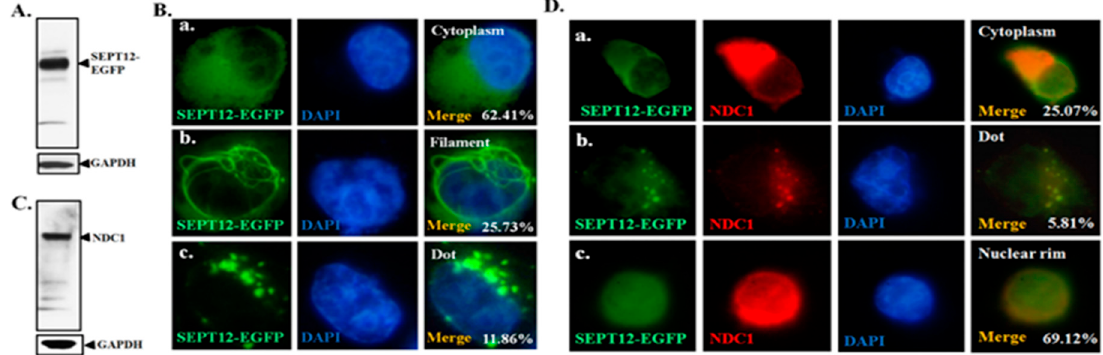
Figure 4. Effects of NDC1 overexpression on SEPT12 localization. ( A ) Western blotting of cells transfected with SEPT12-EGFP; ( B ) IFA results showing SEPT12-EGFP patterns: ( a ) localized at cytoplasm, ( b ) fibrous, or ( c ) dot-like; ( C ) Western blotting of cells with coexpressed SEPT12-EGFP and pFLAG-NDC1; ( D ) IFA results showing SEPT12-EGFP patterns: ( a ) localized at cytoplasm, ( b ) dot-like, or ( c ) localized at nuclear rim; ( B , D ) signals from EGFP protein (green), anti-FLAG antibody (red), DAPI (blue), and combined EGFP, anti-FLAG, and DAPI (“Merge” panels). Magnification = 1000×.